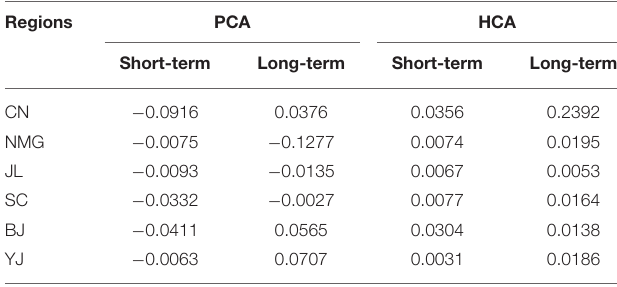
TABLE 4 | The role of physical capital accumulation and human capital channels in the economic growth effect of healthcare expenditure in China’s different regions.